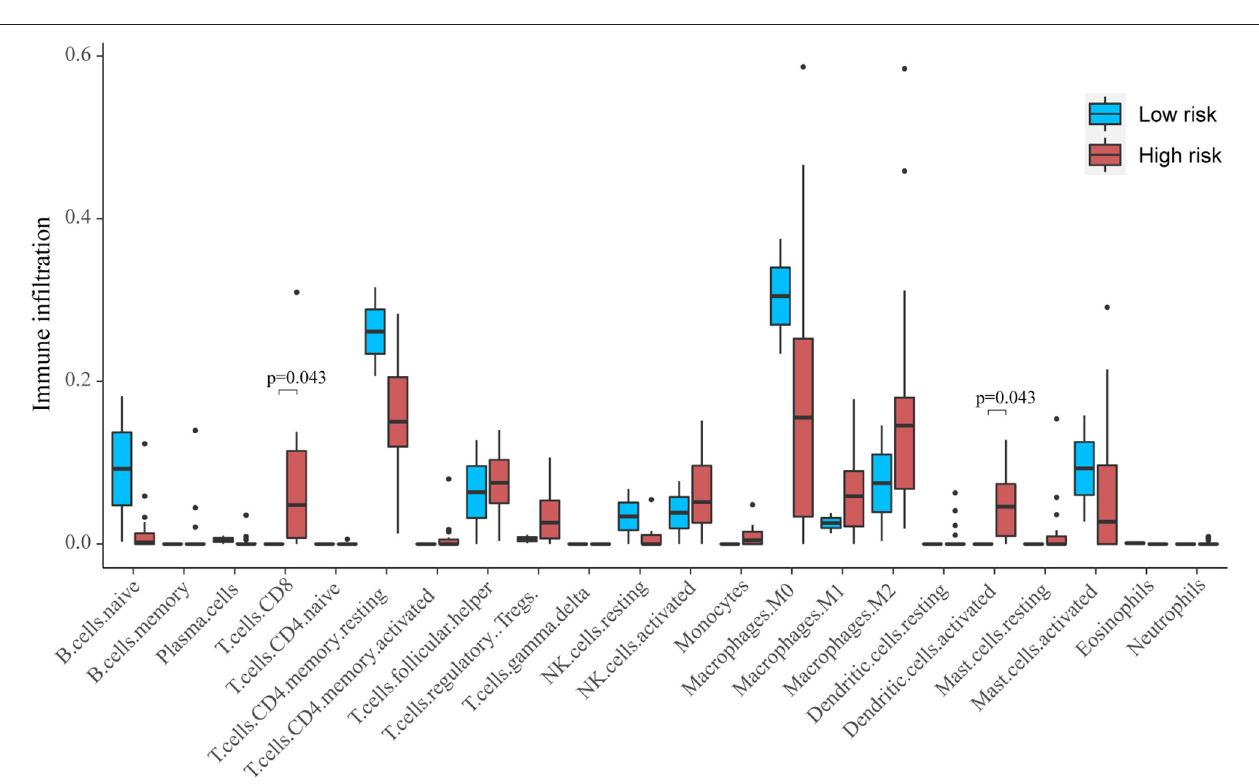
FIGURE 4 | The correlation between the 13-gene score and tumor microenvironment scores. (A) Stromal score; (B) Immune score; (C) ESTIMATE score.